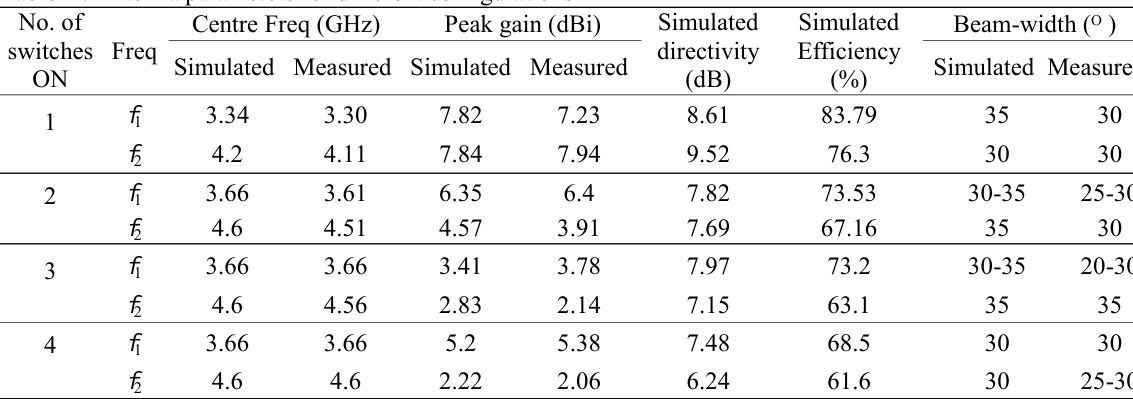
Simulated Beam-width (ᴼ ) directivity Efficiency